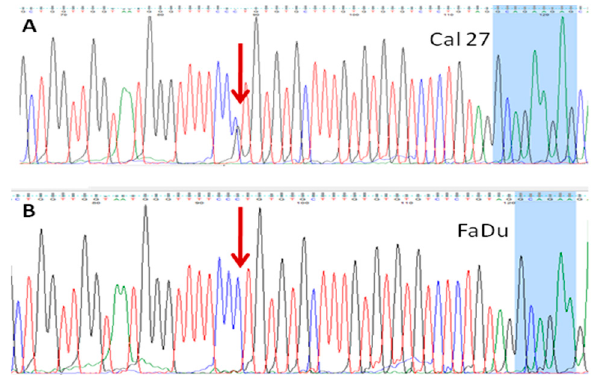
Figure 8. A . Single nucleotide variant, rs 689452, C+G in Cal 27 (also present in Detroit 562) is in intron 1, separated from the 5' part of exon 2 (labeled blue) by only 27 nts. B . In FaDu (shown by an arrow) and IMR-90 (not shown), the sequence was homozygous, C + C.